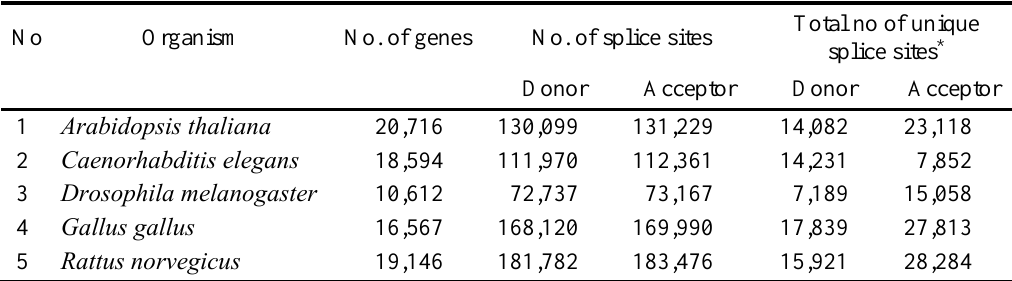
Table 1. Number of genes and splice sites of the organisms